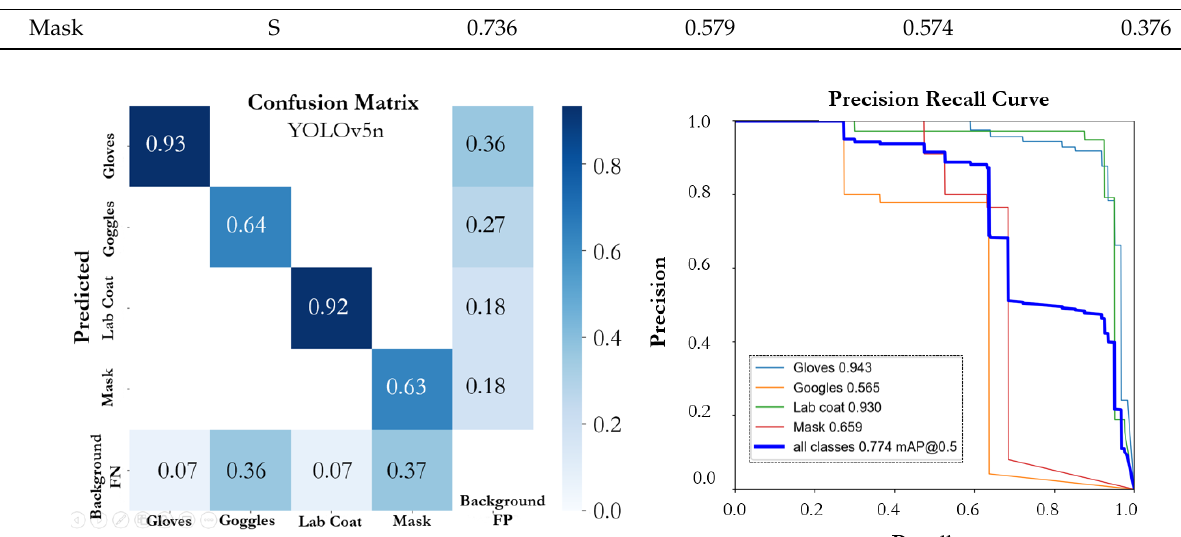
Figure 8. Confusion matrix and PR curve of the YOLOv5n model.